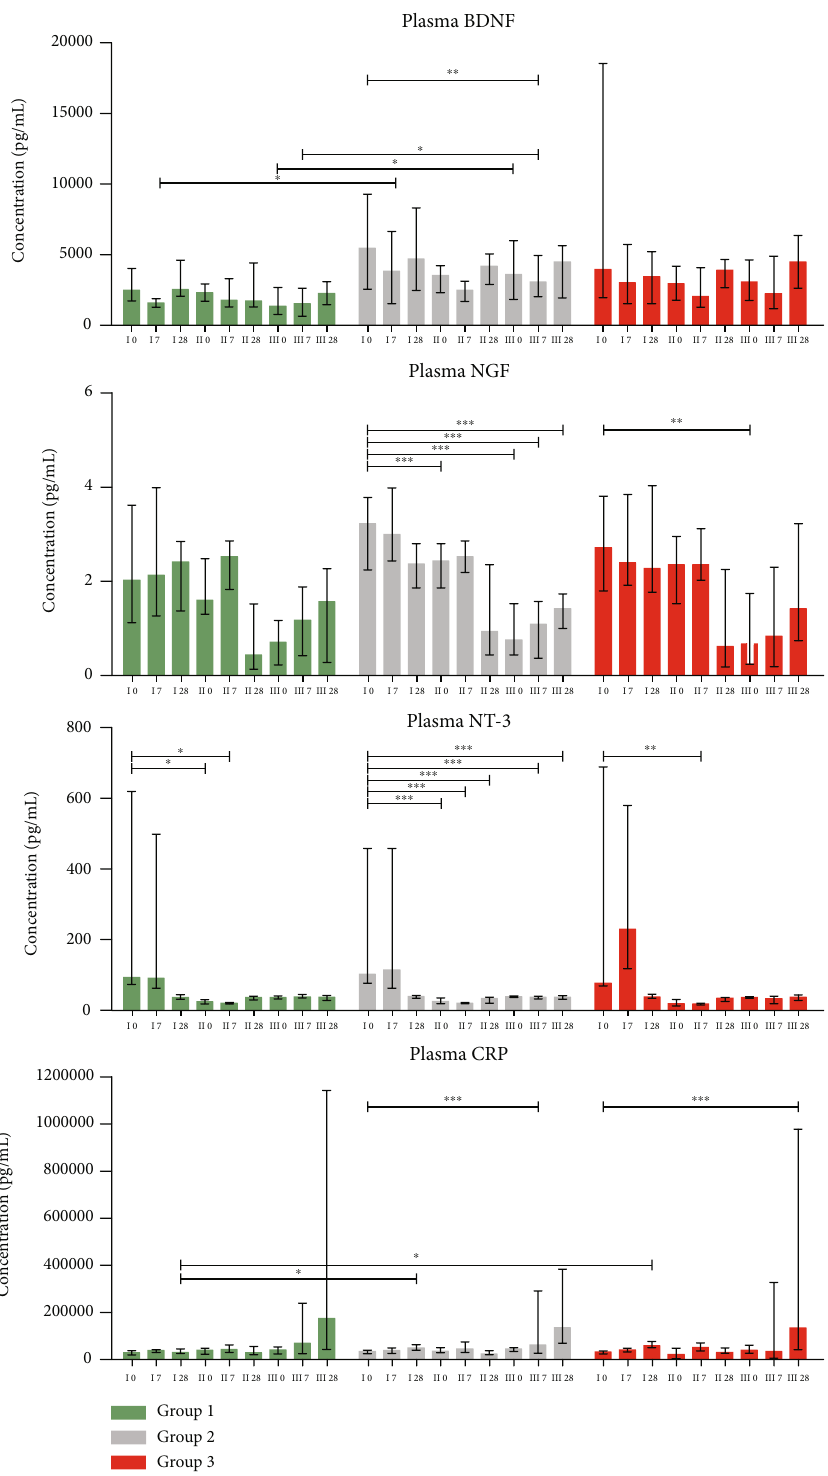
Figure 5: Concentrations of analyzed factors in plasma (pg/mL) of 42 sALS patients divided into three groups, based on the FDA scale results. The samples were collected in nine timepoints presented on the x -axis. Roman numerals represent each Lin − cell administration (I, II, and III), and Arabic numbers stand for the day of sample collection (0, 7, and 28). Data are presented as the median values with an interquartile range. Level of signi fi cance: ∗ p < 0 : 05 , ∗∗ p < 0 : 01 , and ∗∗∗ p < 0 : 001 . BDNF: brain-derived neurotrophic factor; NGF: nerve growth factor; NT-3: neurotrophin 3; CRP: C-reactive